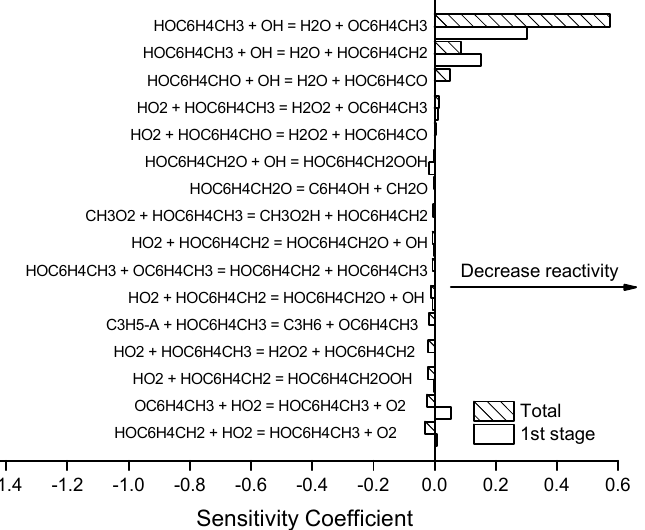
Figure 5. Brute-force sensitivity analysis on the first-stage and total ignition delays of a stoichiometric 80/20 iso -octane/ ortho -cresol mixture. T C = 686 K, P C = 20 bar.